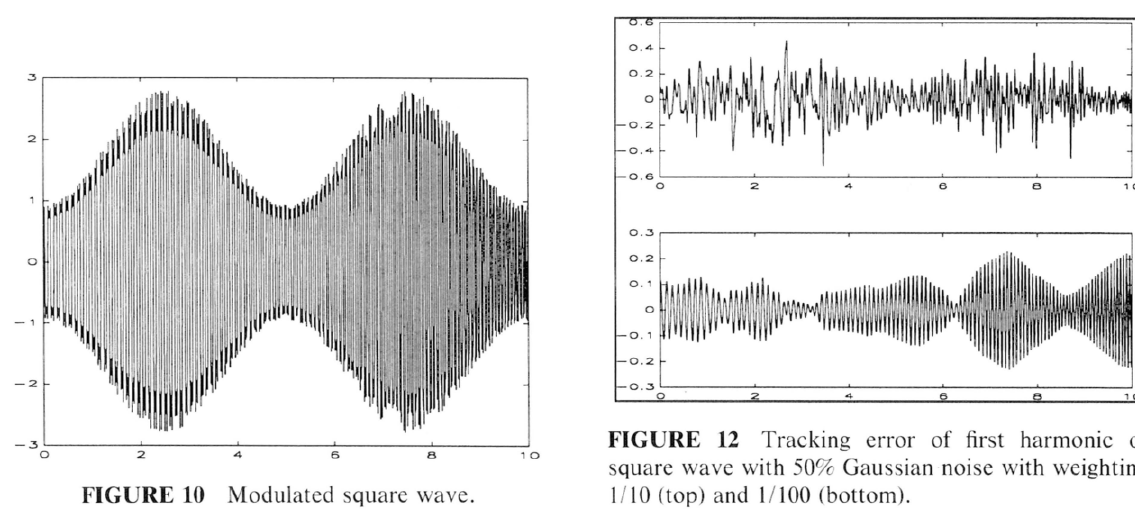
FIGURE 10 Modulated square wave.